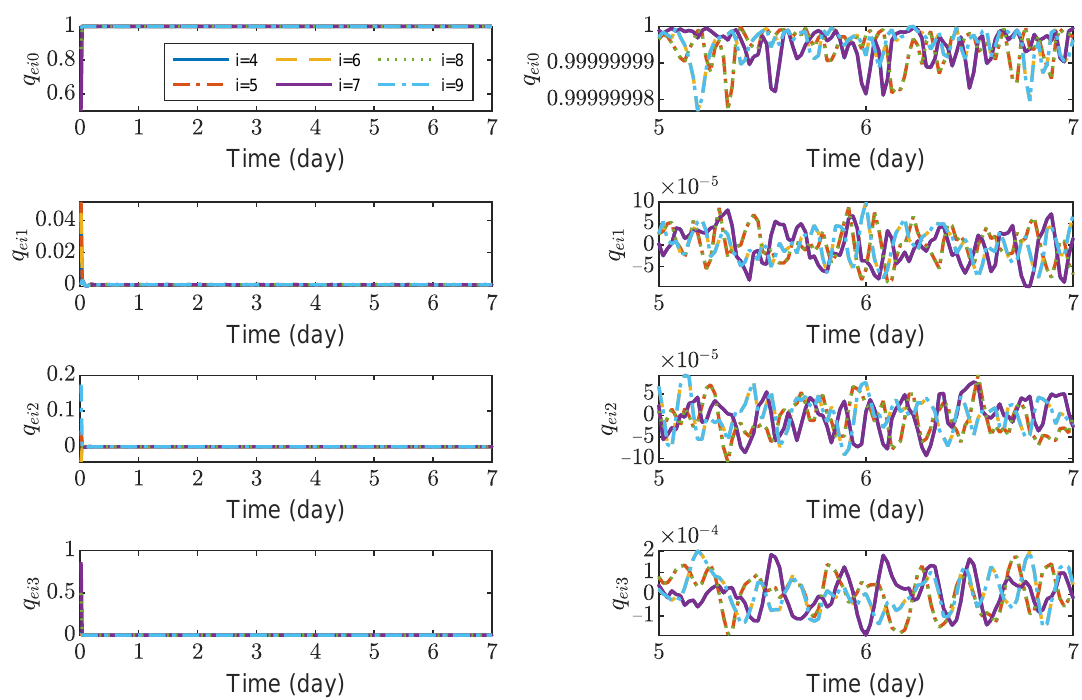
Figure 10. Relative angular velocity errors of spacecrafts TM1 ∼ 6, the max control torque of spacecraft is 100 µ N · m.